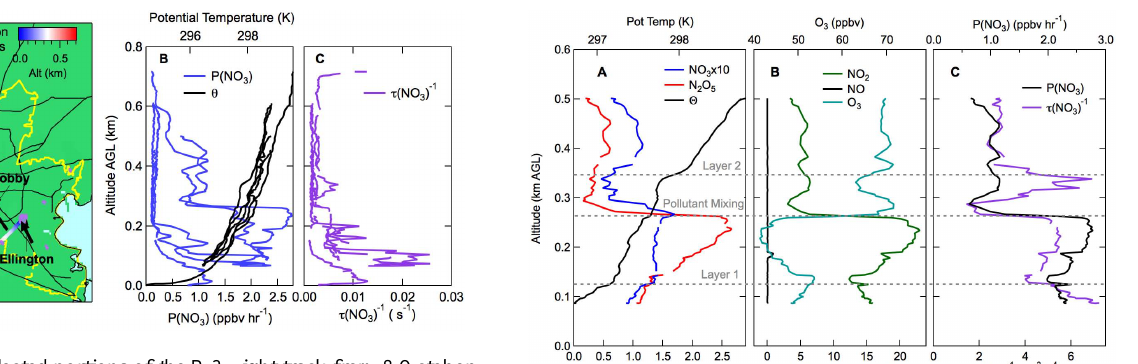
Fig. 2. (A) Selected portions of the P-3 flight track from 8 October 2006 overlaid on a map of the Houston area and color coded by al- titude. Black arrows indicate wind direction and relative speed. The selected flight track includes low approaches to Hooks and Hobby, followed by landing at Ellington after an extended level leg (level portion not shown). (B) Vertical profiles of potential temperature (top axis) and P (NO 3 ) (bottom axis, see text) for all five vertical profiles (four from the low approaches, one from landing). (C) In- verse steady state NO 3 lifetime, τ (NO 3 ) − 1 (see text).